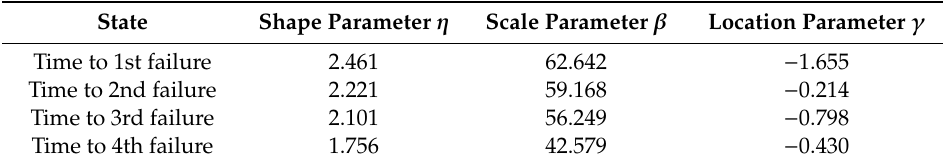
Table 6. Parameters of the Weibull fitting for each state (CI < 150